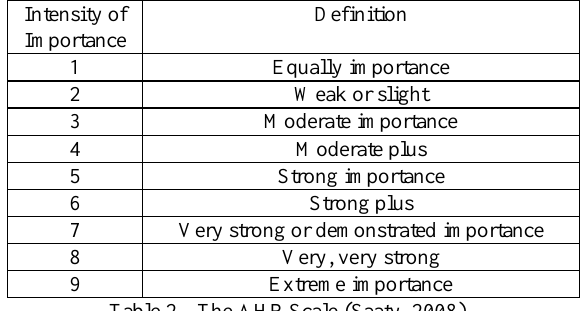
Table 2. The AHP Scale (Saaty, 2008)